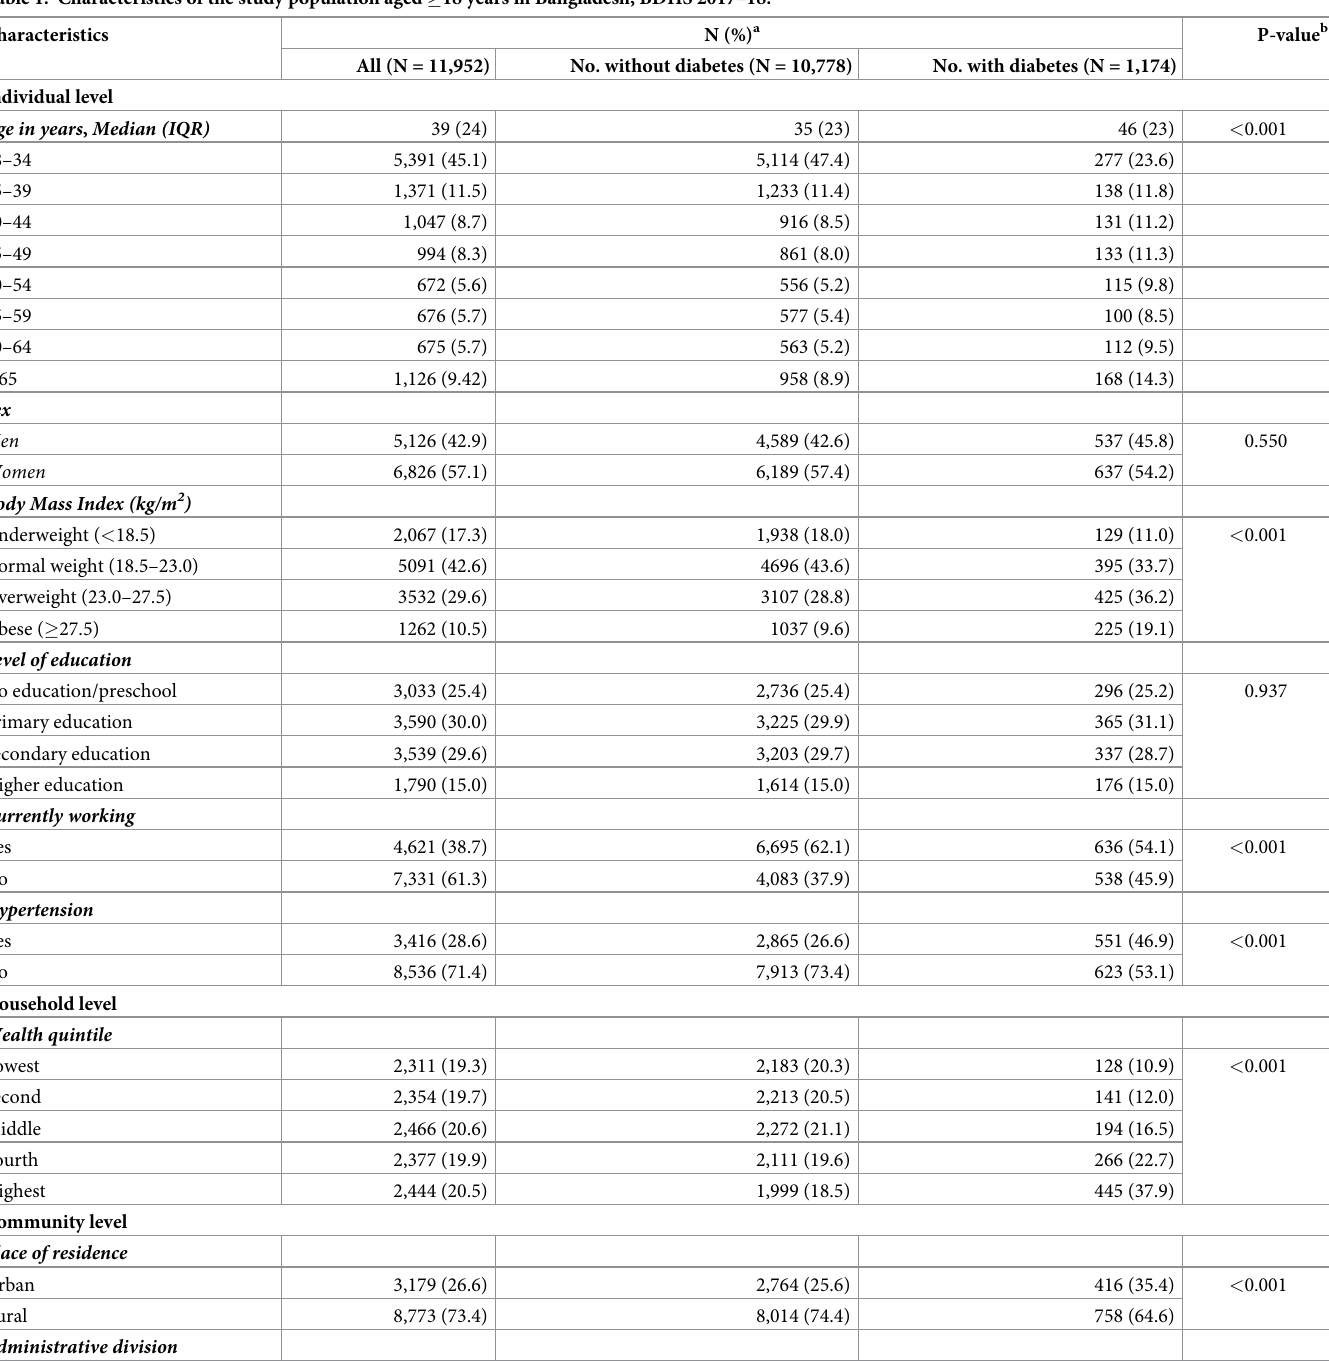
Table 1. Characteristics of the study population aged � 18 years in Bangladesh, BDHS 2017–18.